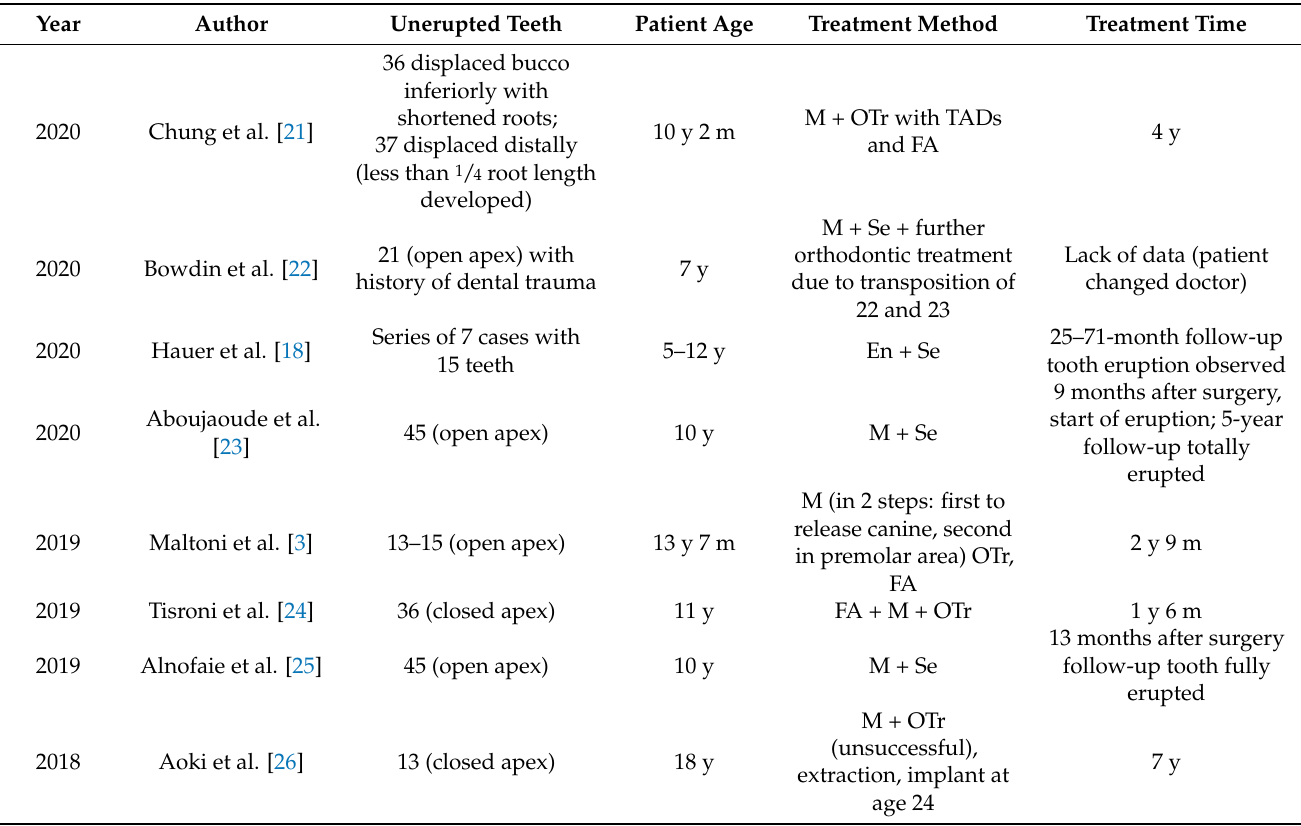
Table 3. Summary of case reports from 2016 to